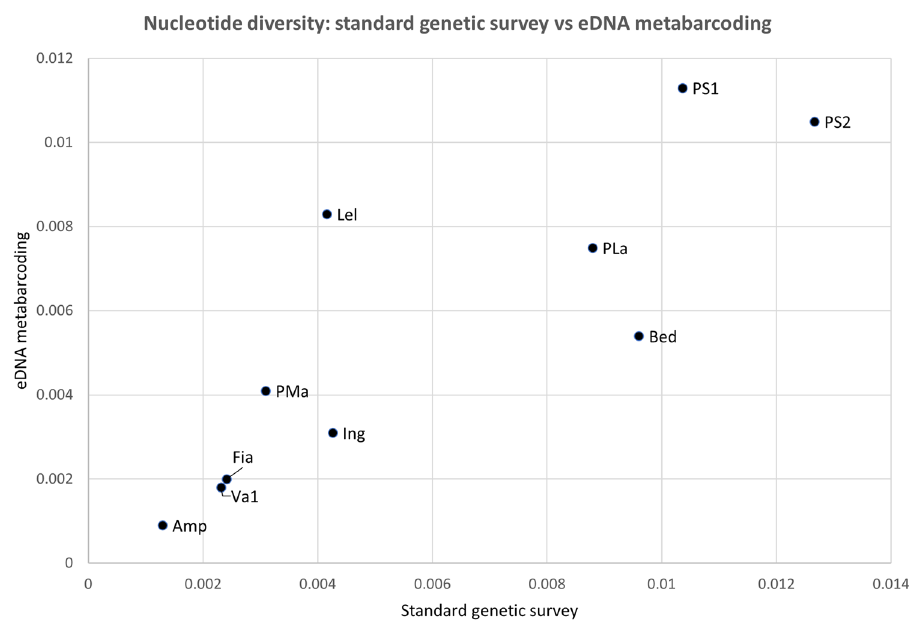
Figure 2. Scatterplot of the correlation between the nucleotide diversity index values for Rana temporaria in the Province of Trento Italy, for two datasets: x-axis: standard tissue-based genetic survey 41 ; y-axis: current study (eDNA